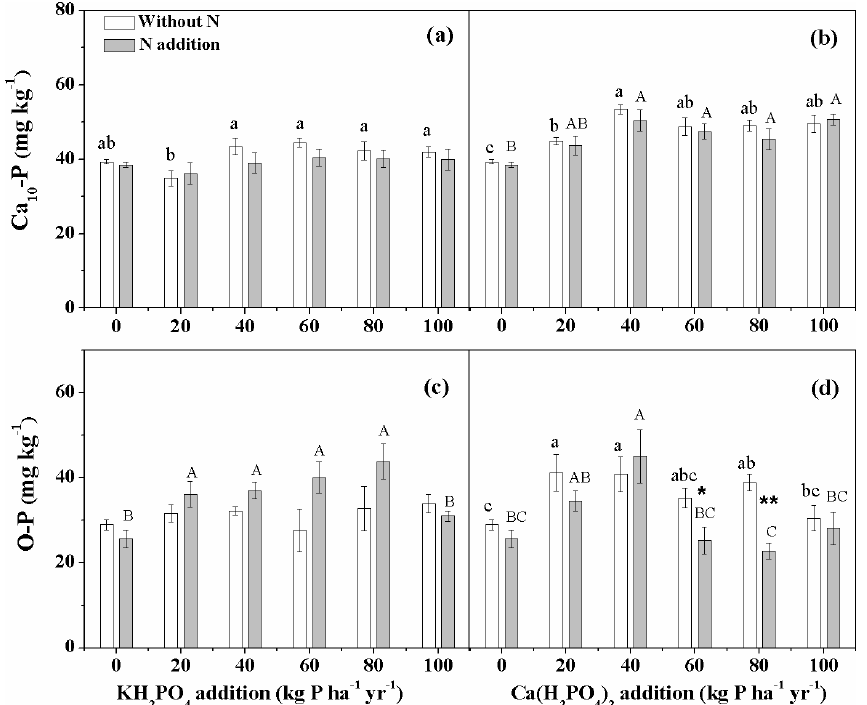
Figure 4. Effects of phosphorus (P) and nitrogen (N) additions on soil hydroxylapatite (Ca 10 -P) and occluded P (O-P). Phosphorus types include KH 2 PO 4 and Ca ( H 2 PO 4 ) 2 at rates of 0, 20, 40, 60, 80 and 100kgPha − 1 yr − 1 . Data are represented as mean ± standard error. Letters indicate significant differences between P rates of KH 2 PO 4 or Ca ( H 2 PO 4 ) 2 addition without N (lowercase letters) and with N addition (capital letters). Asterisks represent significance between N treatments within each P type and rate ( ∗ and ∗∗ for P < 0 . 05 and 0.01,